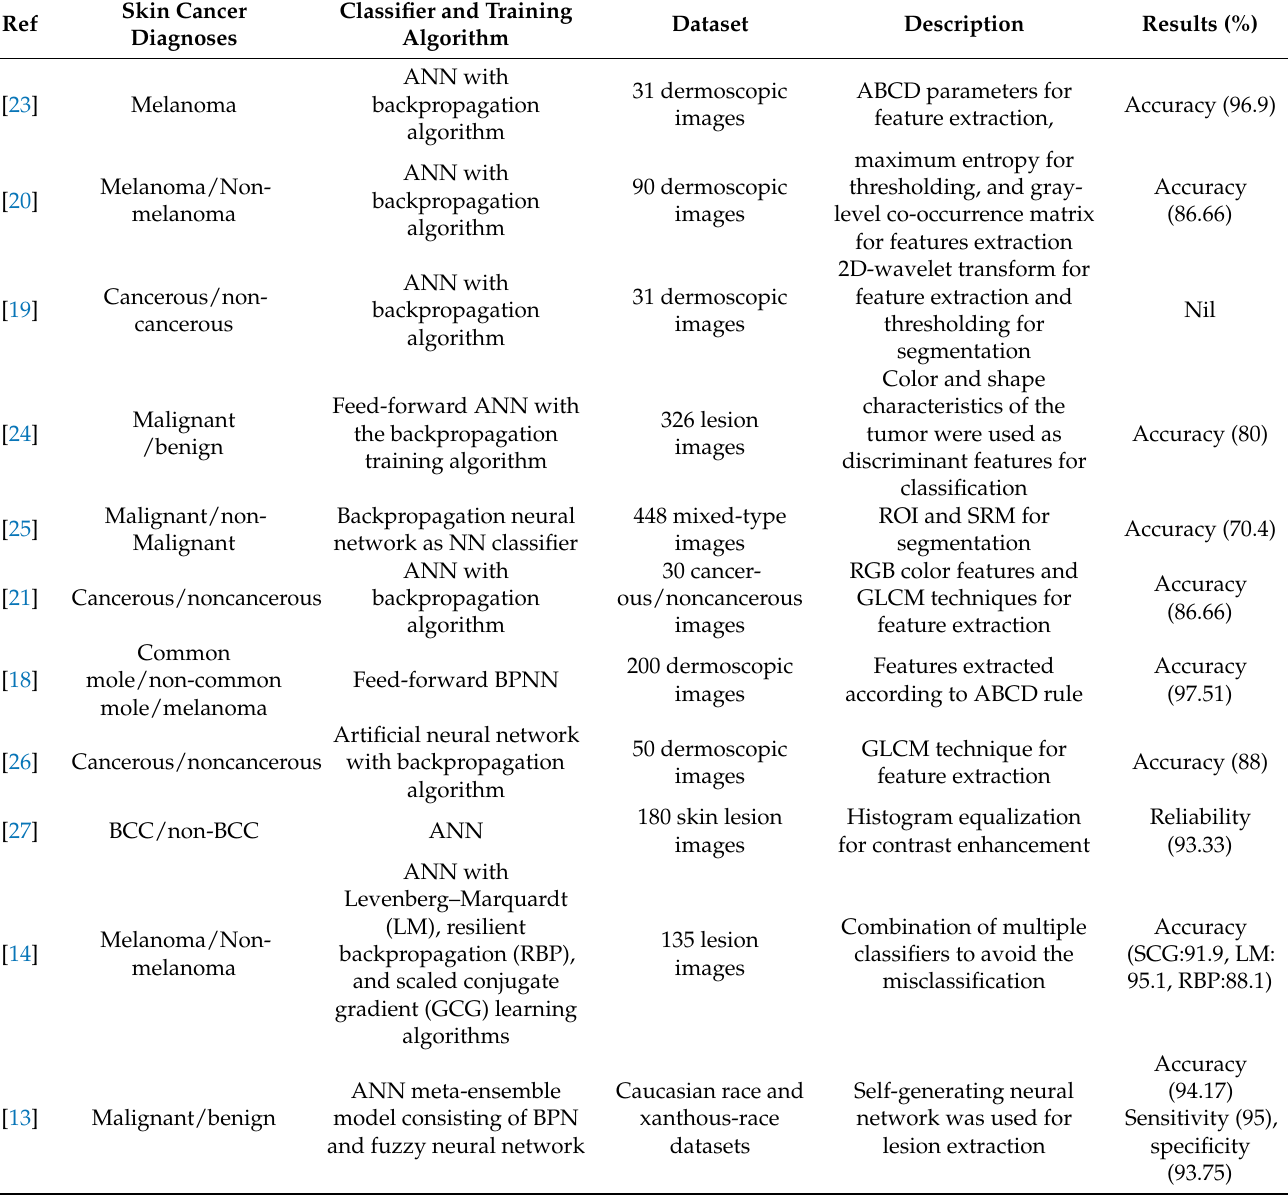
Table 3. A comparative analysis of skin cancer detection using ANN-based approaches.